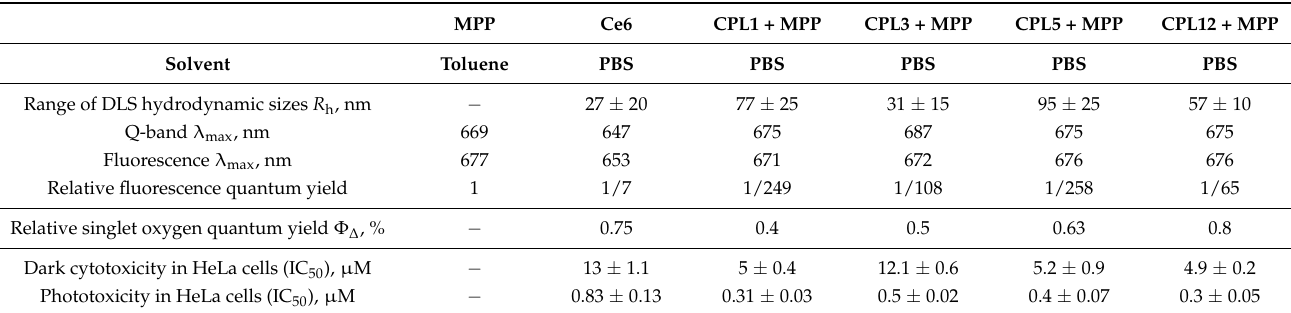
Table 2. A comparison of photophysical properties and photodynamic activity of reference PS and